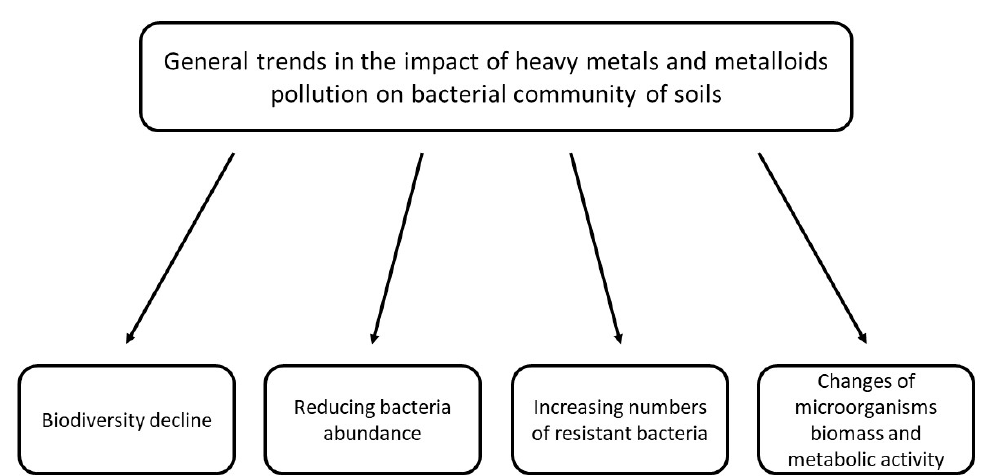
soil Figure 1. General trends in the impact of heavy metal and metalloid pollution on bacterial soil com- munities.